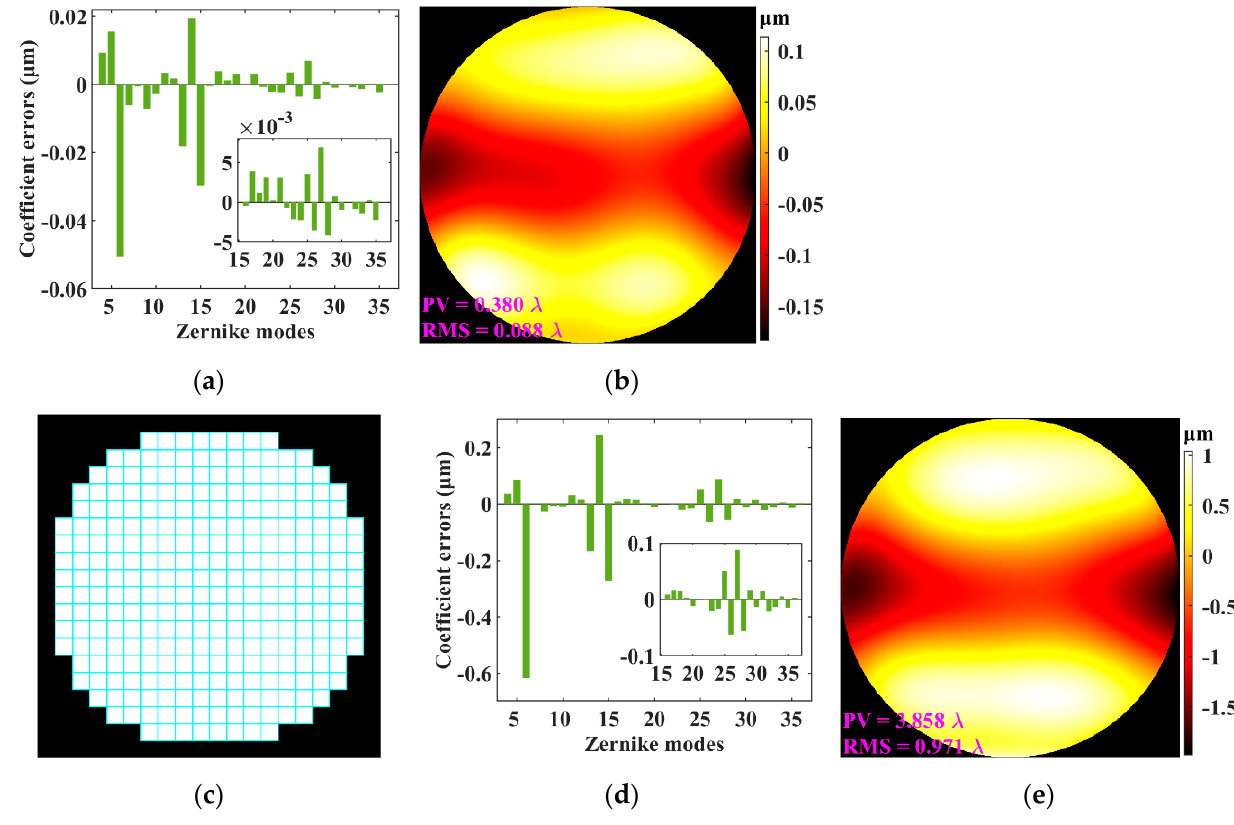
Figure 2. Results of vSHWS using round and square lenslets. ( a ) Zernike coefficient errors and ( b ) wavefront error when using round lenslets; ( c ) arrangement of square lenslets; ( d ) Zernike coefficient errors and ( e ) wavefront error when using square lenslets.